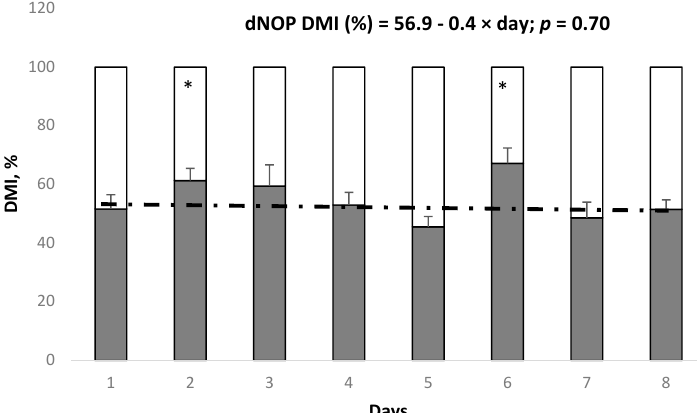
Figure 3. Proportions of DMI of animals ( n = 9) fed a high grain diet without (white portion in the bars) or with 3-NOP (black portions in the bars) during the preference period (Exp. 2). The symbol * indicates that the proportion of CON diet consumed minus proportion of 3-NOP diet consumed within day is not equal to 0 ( p < 0.05). Day 1 to 8 corresponds to the 8 d preference period. The dashed line indicates the linear regression of intake of 3-NOP diet, as a percentage of total daily dry matter intake (dNOP DMI, %), as a function of day.